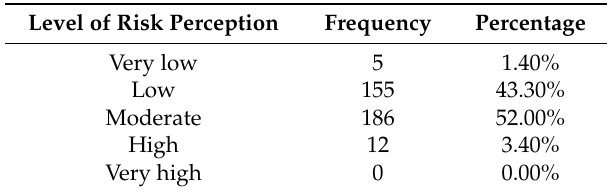
Table 6. Overall risk perception level.